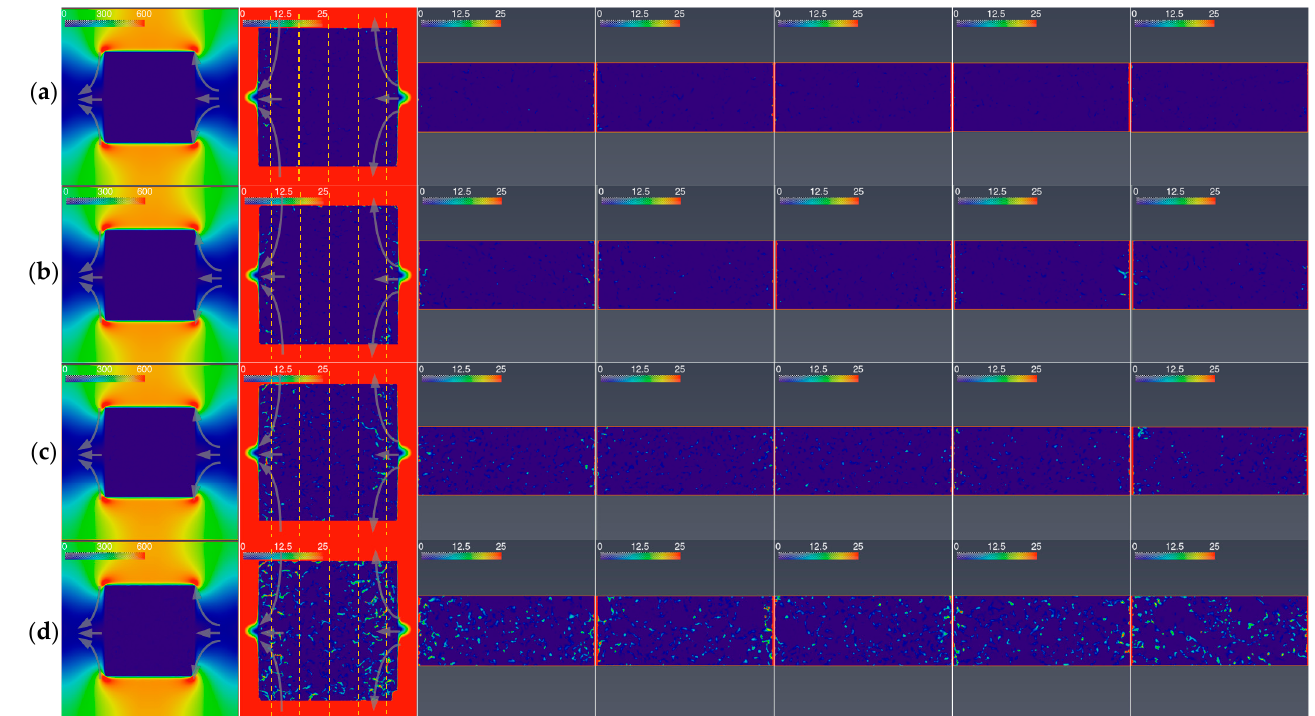
Figure 15. Gas velocity distributions for large cuboid graphite specimens: ( a ) as-received; ( b ) oxidized for 4 min; ( c ) oxidized for 8 min; ( d ) oxidized for 24 min.